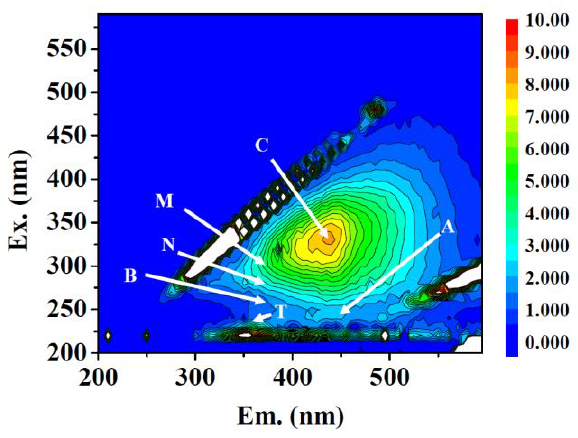
Figure 3. An example of the 3DEEM fluorescence spectrum for the river water sample collected from site 4 of Oyabe River. The bar chart next to the graph indicates contour intervals of the fluorescence intensity in the quinine sulfate normalization